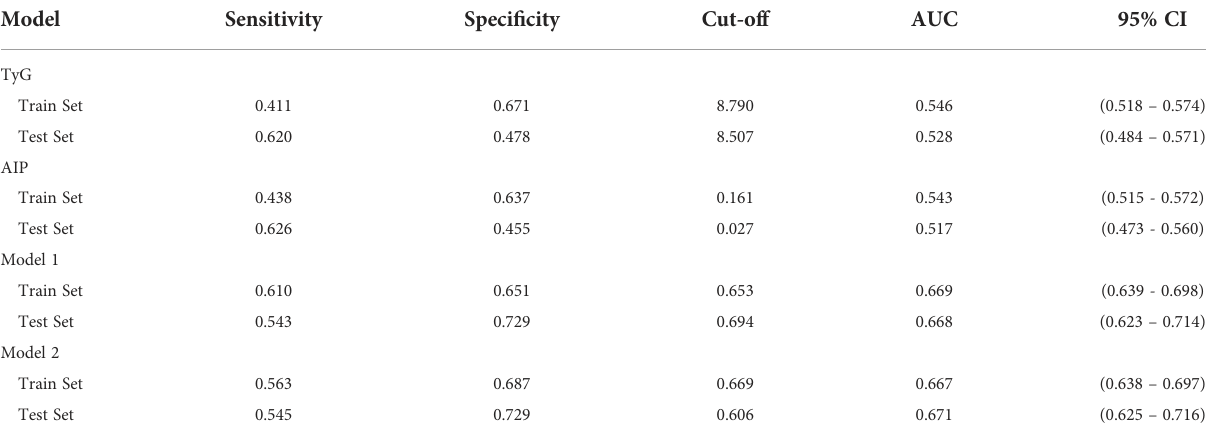
TABLE 3 Diagnostic accuracy of TyG and AIP